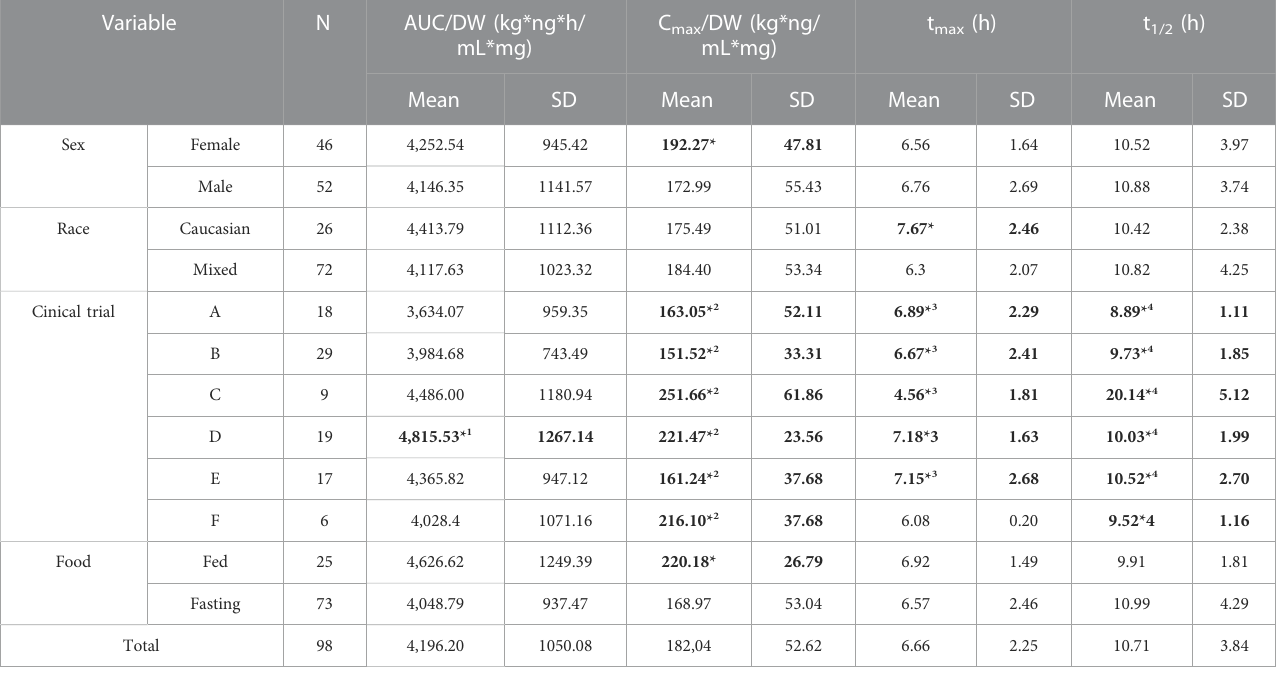
TABLE 4 Pharmacokinetic parameters according to sex, race, clinical trial, and food administration conditions. Variable